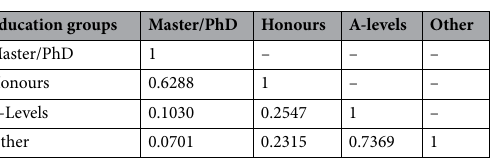
Table 5. P values based on paired Wilcoxon tests for UX scores in four education groups.